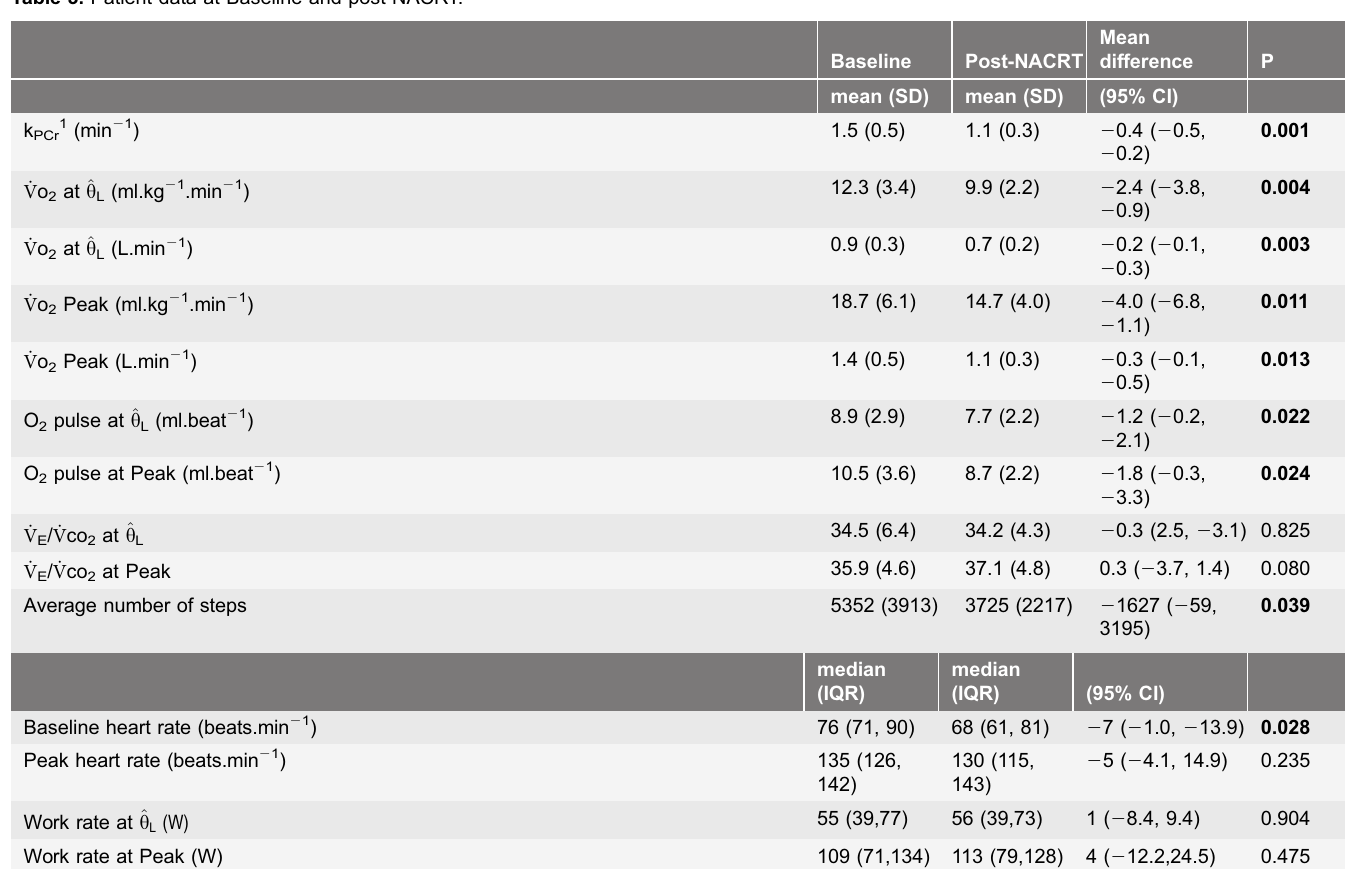
Table 3. Patient data at Baseline and